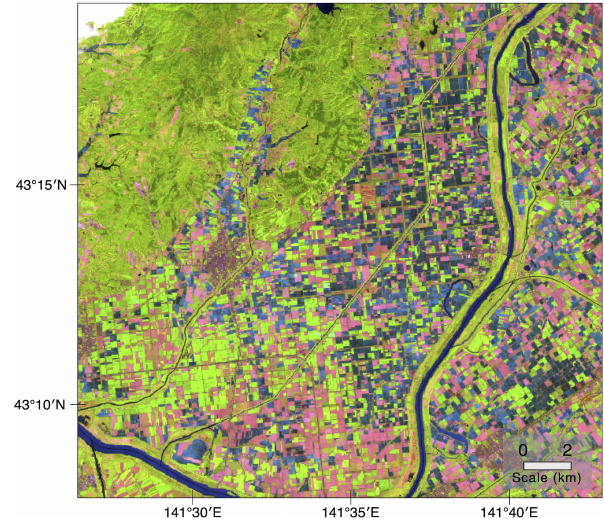
Figure 3. Color composited satellite image of bands of red (R), near-infrared (NIR) and short-wave infrared (SWIR), of Sentinel-2 taken on 28 May 2016 covering Shinotsu Peatland. RGB = (SWIR, NIR, R). Green area, pink area, and blue area represent upland fields with vegetation, upland fields with no vegetation, and paddy fields, respectively.